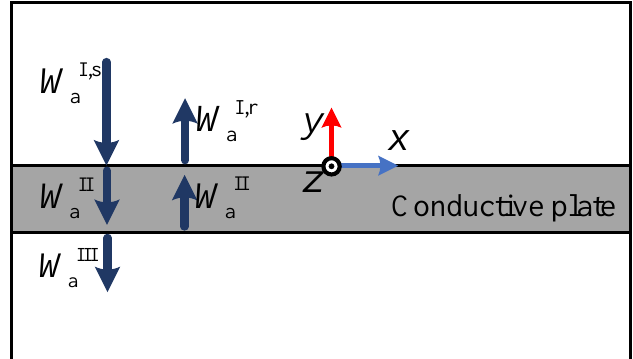
Figure 6. Source, reflected and transmitted TE